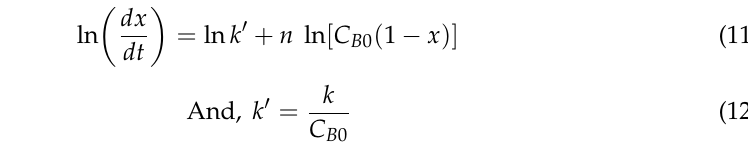
Table 4. 1/ T vs. ln k graph for the WCO transesterification process